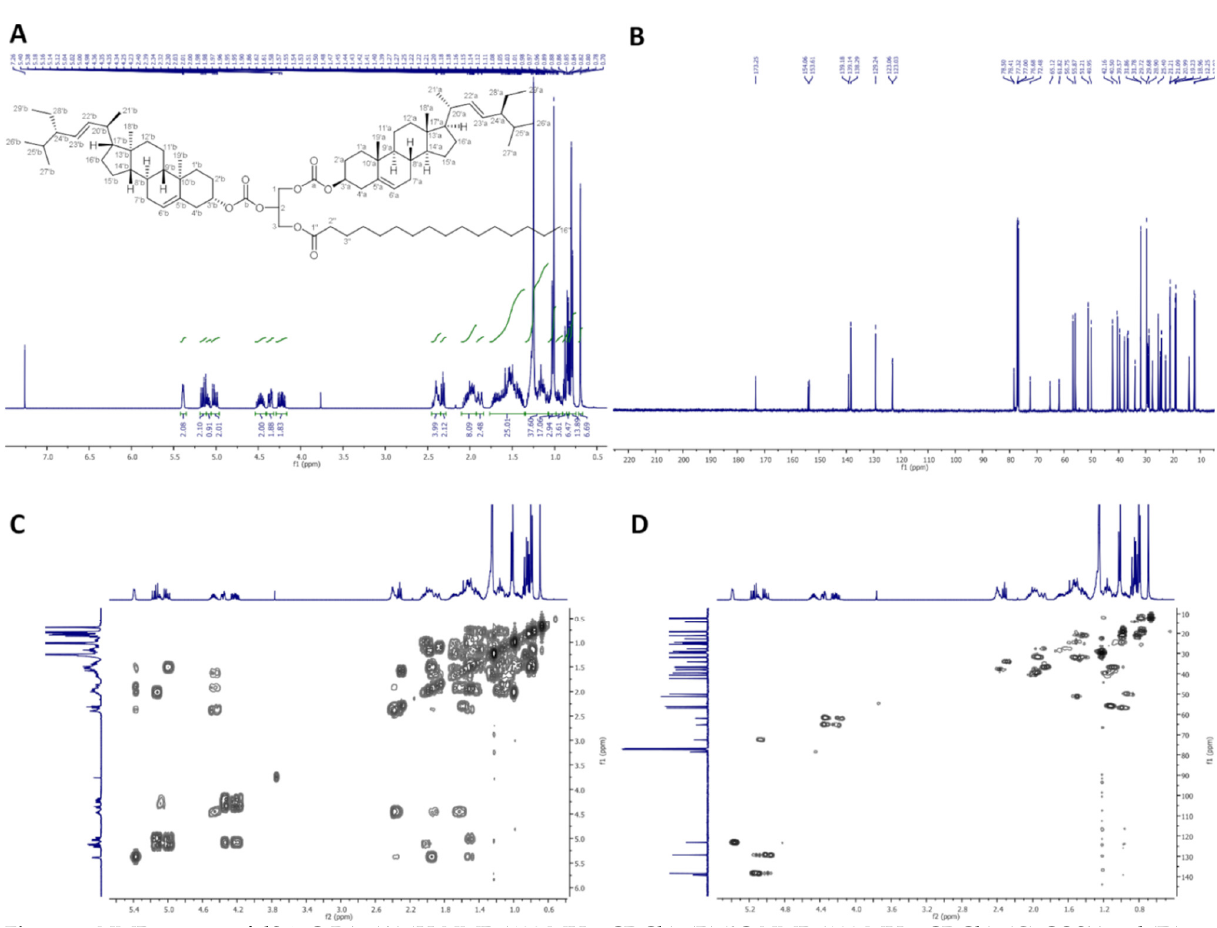
Figure 4. NMR spectra of dStigC-PA: ( A ) 1 H-NMR (400 MHz, CDCl 3 ), ( B ) 13 C-NMR (100 MHz, CDCl 3 ), ( C ) COSY and ( D ) HMQC.